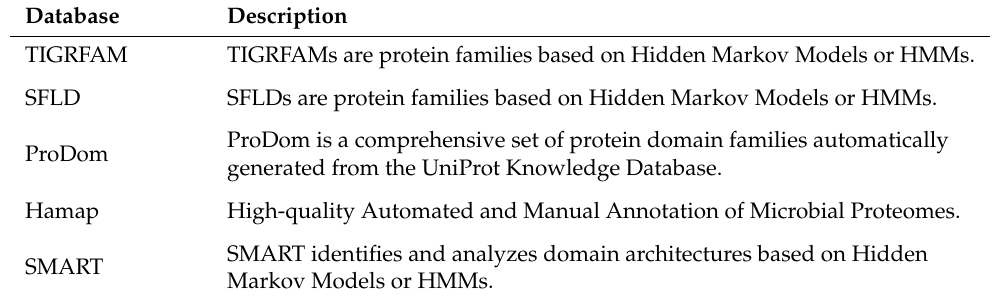
Table 2. Databases used by InterProScan version 5.45-80 for